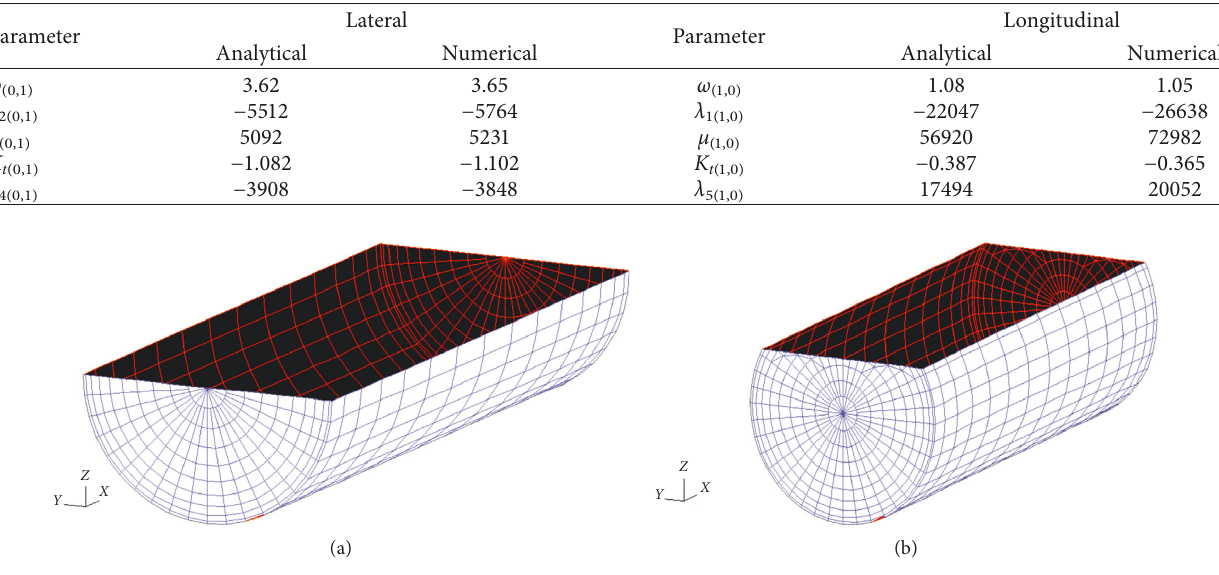
Figure 4: Numerical model of horizontal circular tank: (a) h